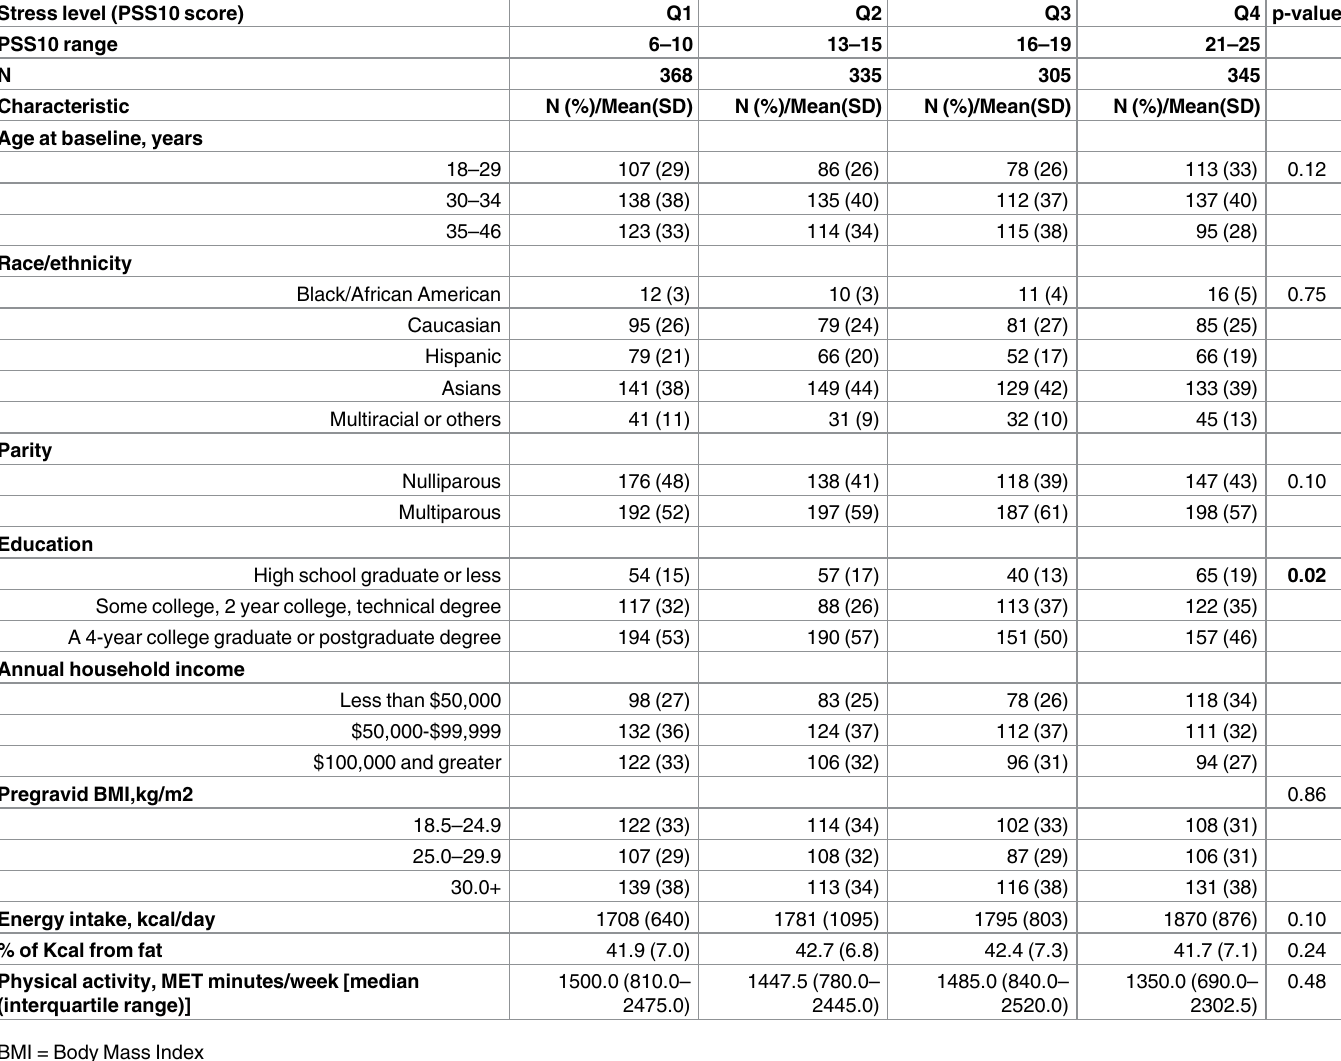
Table 1. Demographic characteristics by perceived stressscale (PSS) score; Gestational Diabetes Effects’ on Mom (GEM) study. Stress level (PSS10